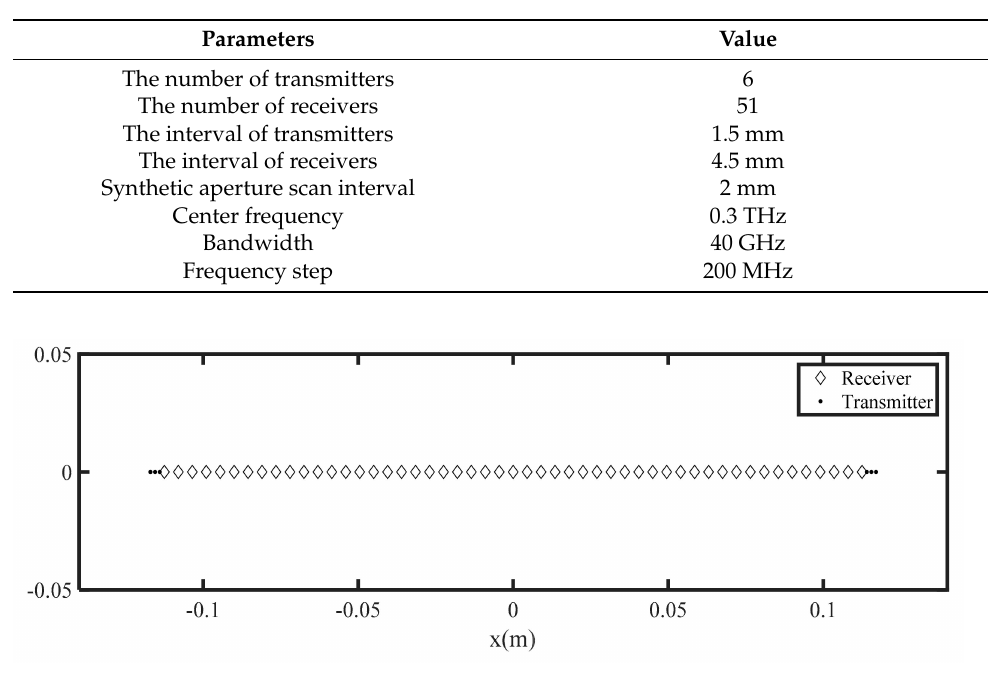
Table 4. Simulation Parameters.